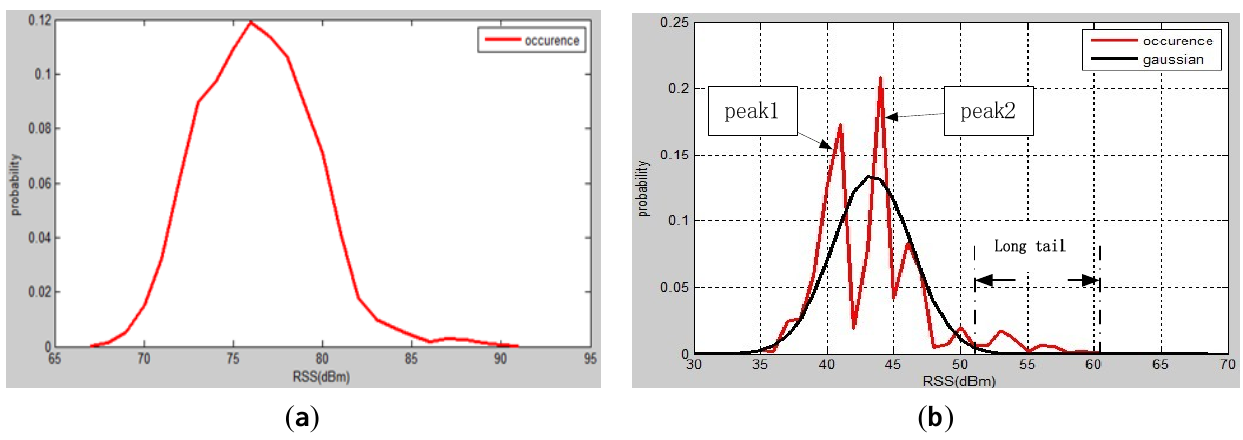
Figure 2. Distribution characteristics of Wi-Fi signals in indoor test environments: